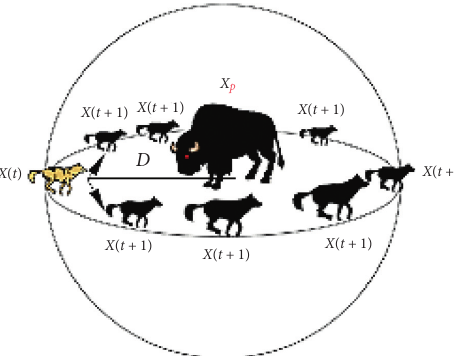
Figure 2: Graphical representation of Grey wolf hunting procedure in a circle or sphere space around the prey ( X p ) based on the direction ( D ) between the wolf ( X ( t ) ) and the prey [13].